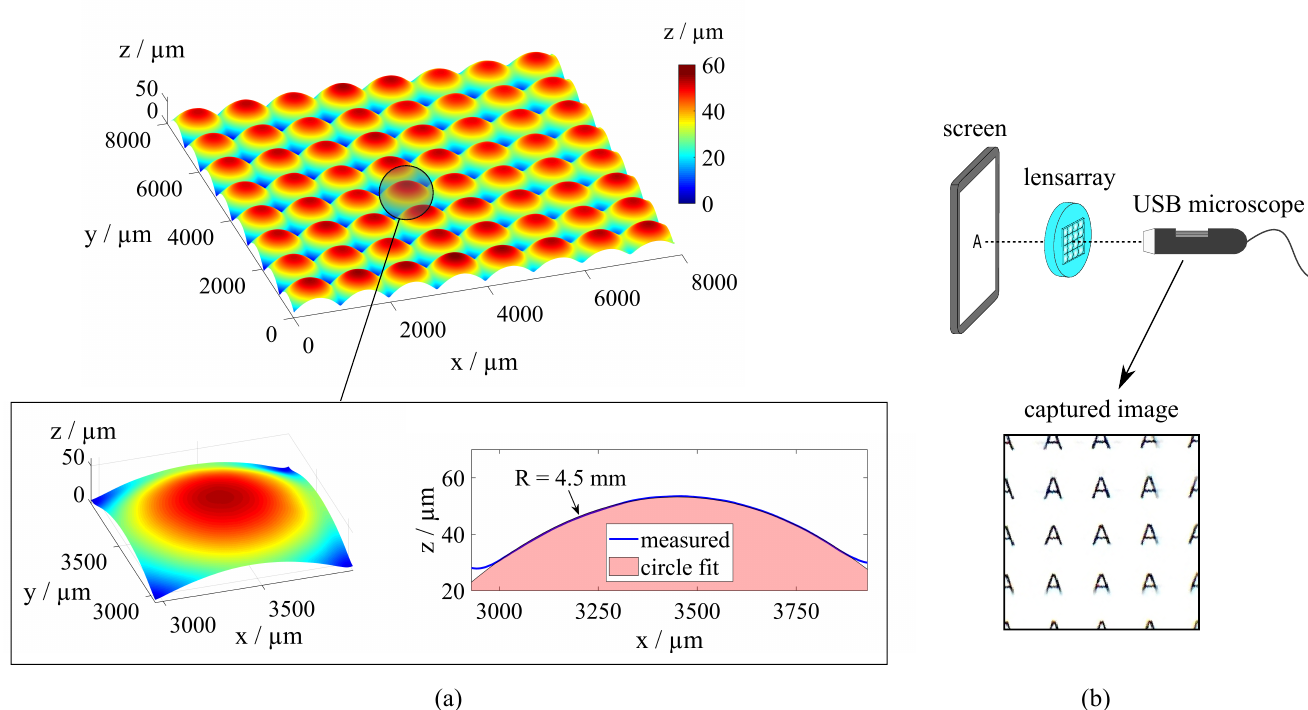
Figure 3. Evaluation of the fabricated lens array ( a ) laser-scanning microscope image of the 8 × 8 lens array with magnification and cross-section of a single lens element ( b ) schematic setup for optical testing of the microlens array with the letter “A”, including a screen, a lensarray and a USB microscope and a section of the captured image.